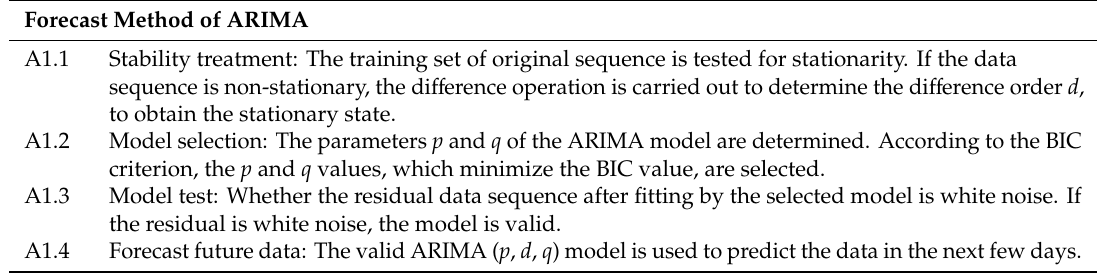
Table 1. Flow of data forecast based on the autoregressive integrated moving average (ARIMA) model. Forecast Method of